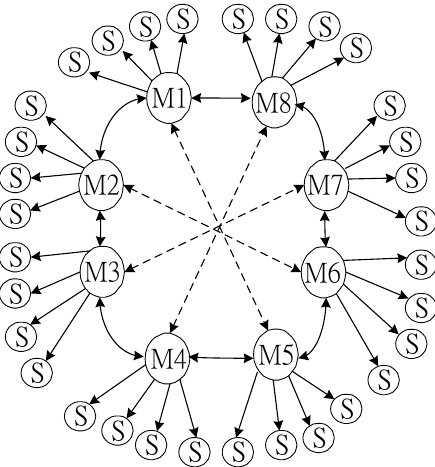
Figure 1. An illustrated Mesh-Ring topology example.